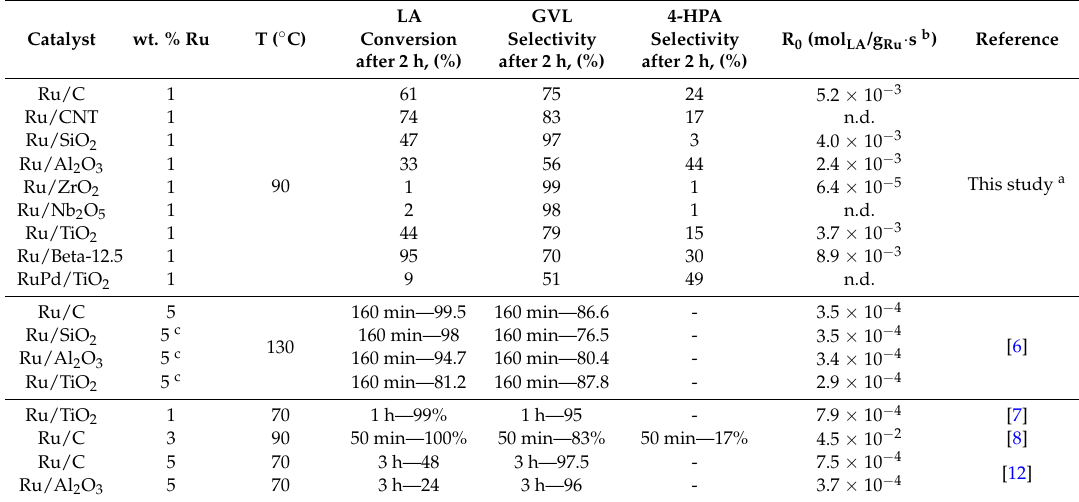
Table 5. Catalyst activity data for LA hydrogenation in water in batch